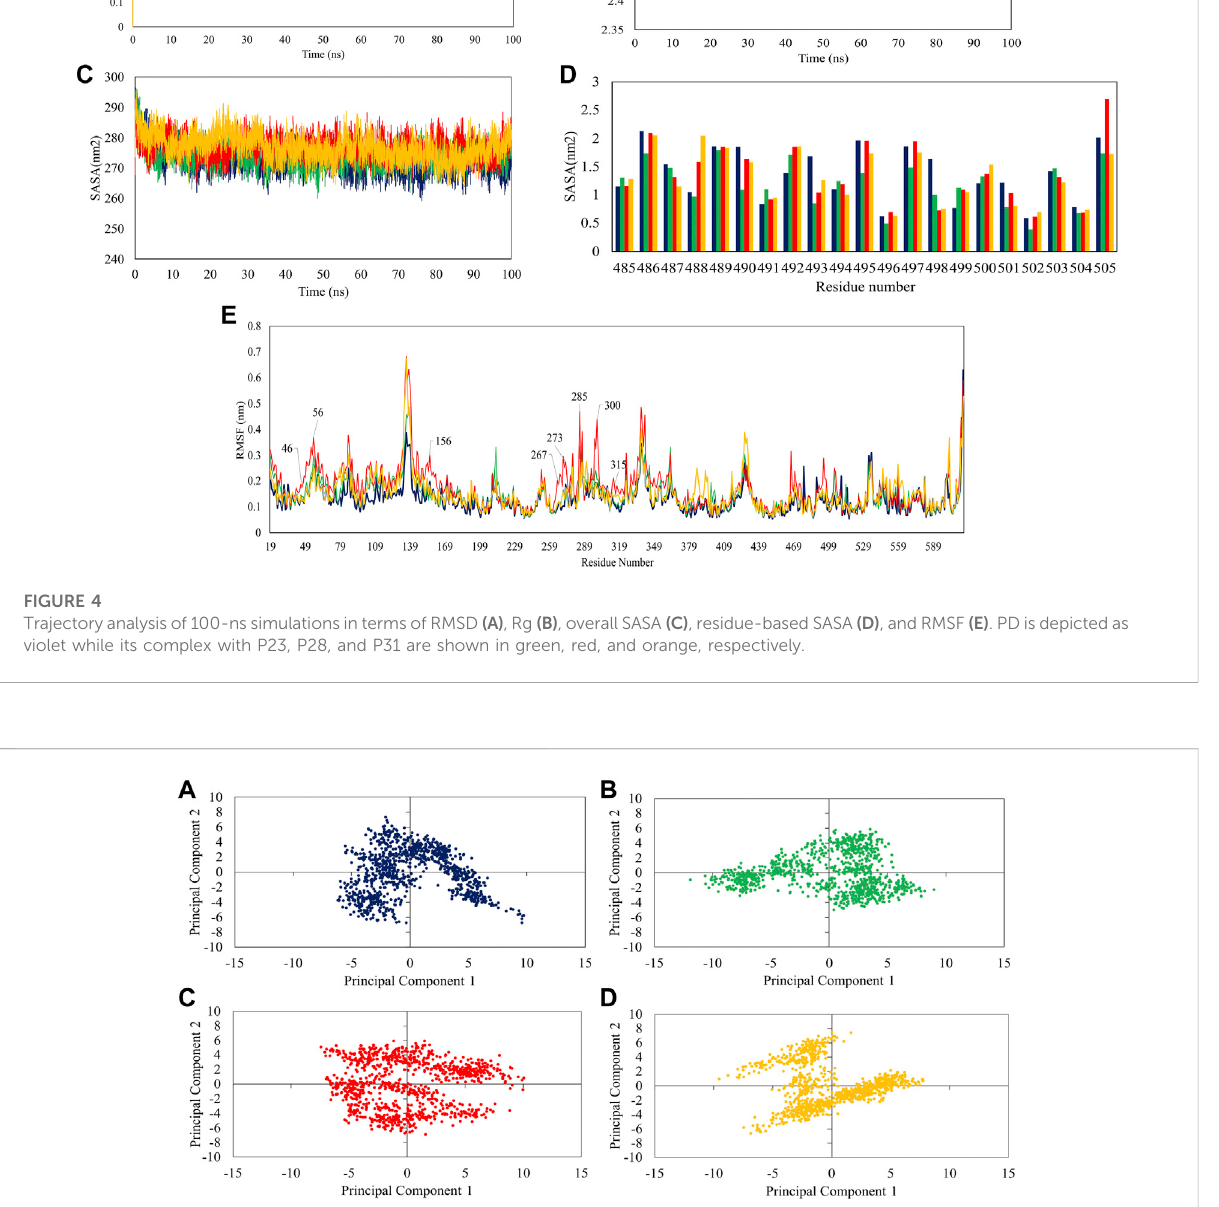
FIGURE 5 2D-projection of protein motions along the fi rst (PC1) and second (PC2) principal components for free PD (A) and bound with P23 (B) , P28 (C) , and P31 (D) .